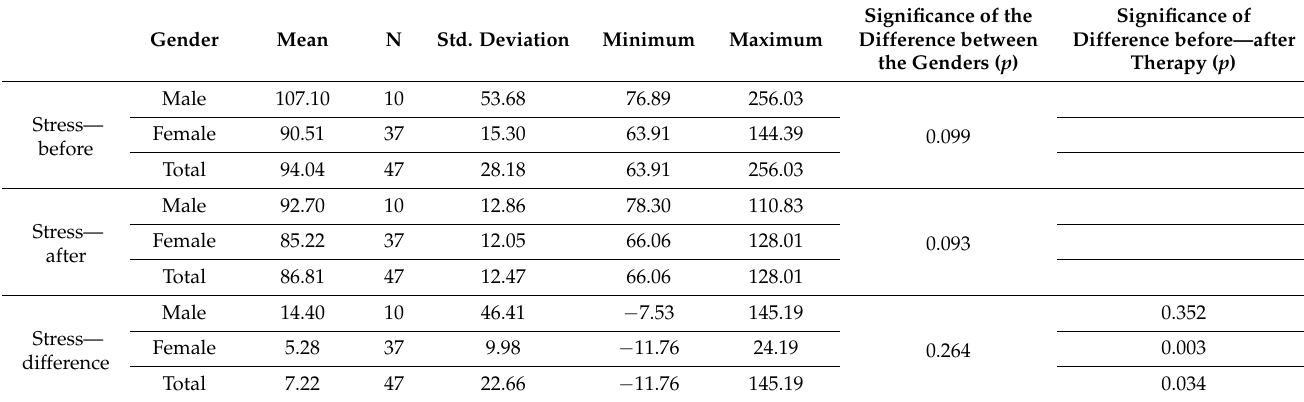
Table 4. Average values of the stress index before and after forest